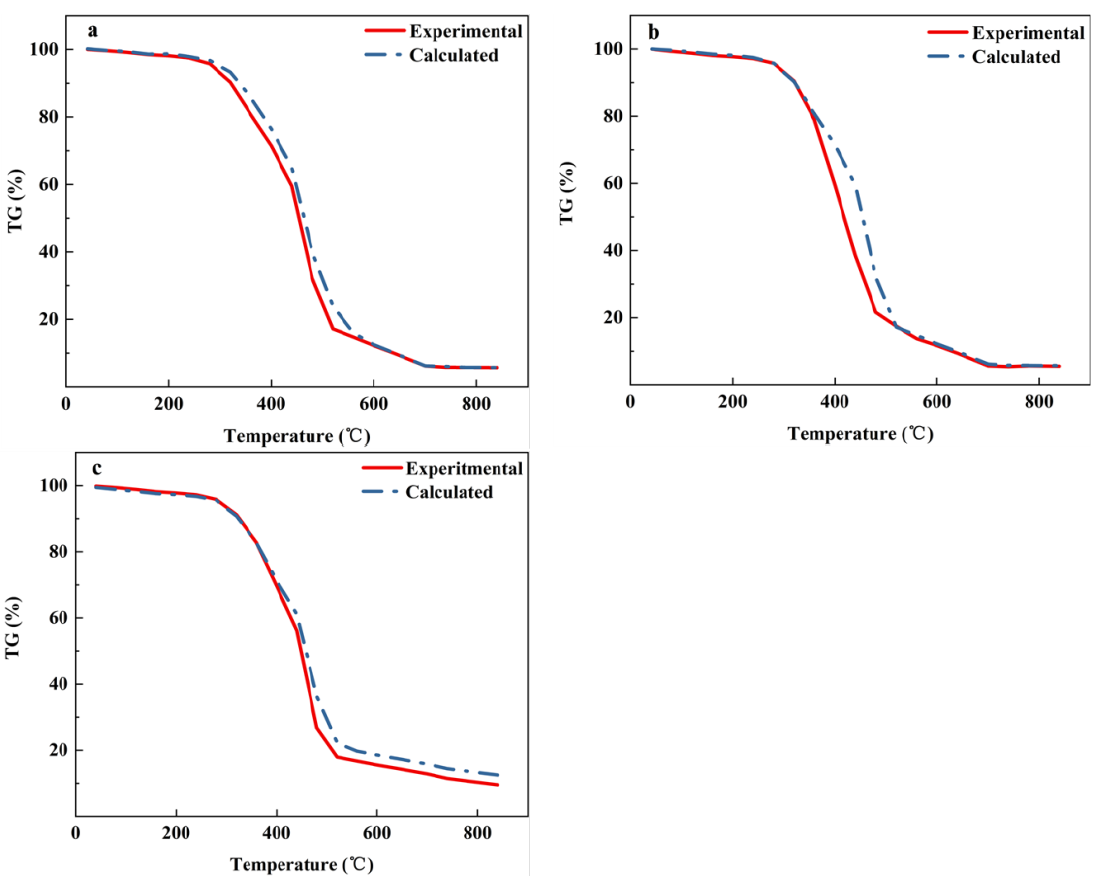
Figure 6. Theoretical and practical TG curves for the co-pyrolysis of MS and PP at different heating rates. ( a ) 10 ◦ C · min − 1 ; ( b ) 20 ◦ C · min − 1 ; ( c ) 30 ◦ C · min − 1 . Table 2. Pyrolysis kinetic parameters of MS, PP, and SP11 at different heating